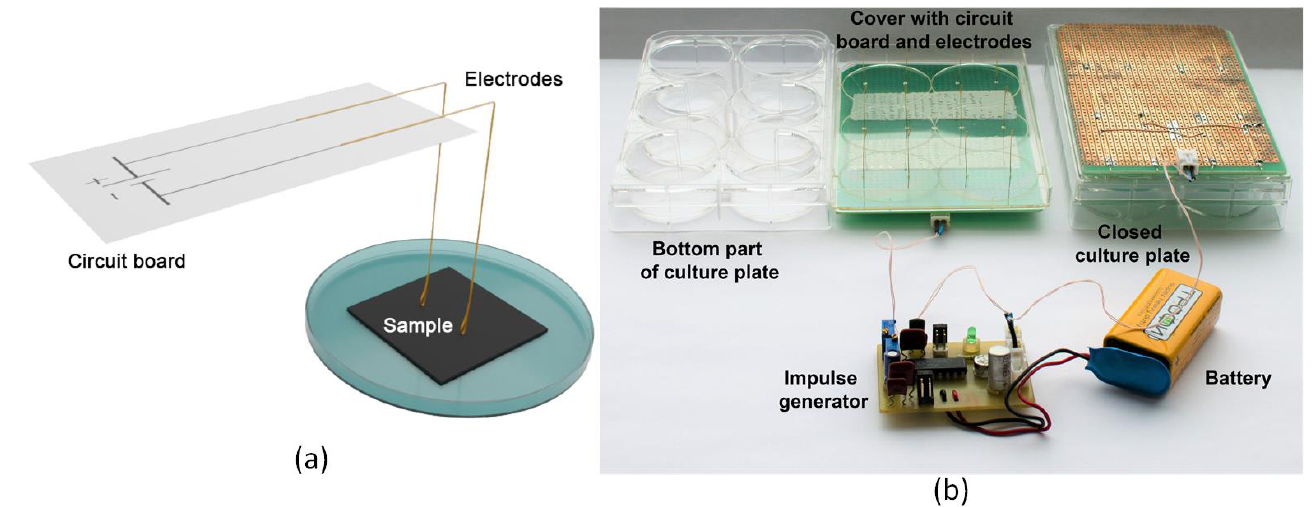
Figure 2. Schematic view ( a ) and photograph ( b ) of experimental setup for electrical stimulation of cell growth.